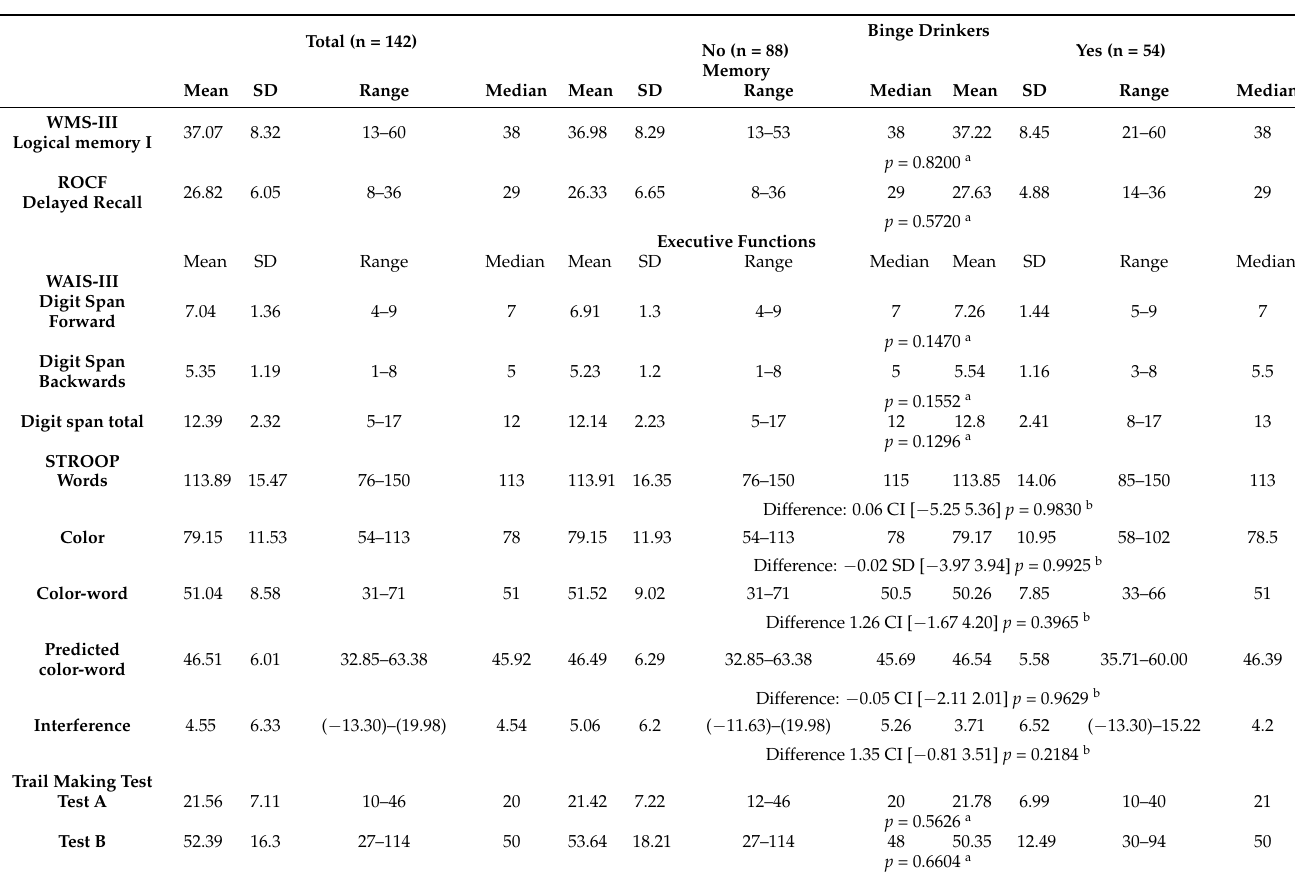
Table 3. Memory and executive